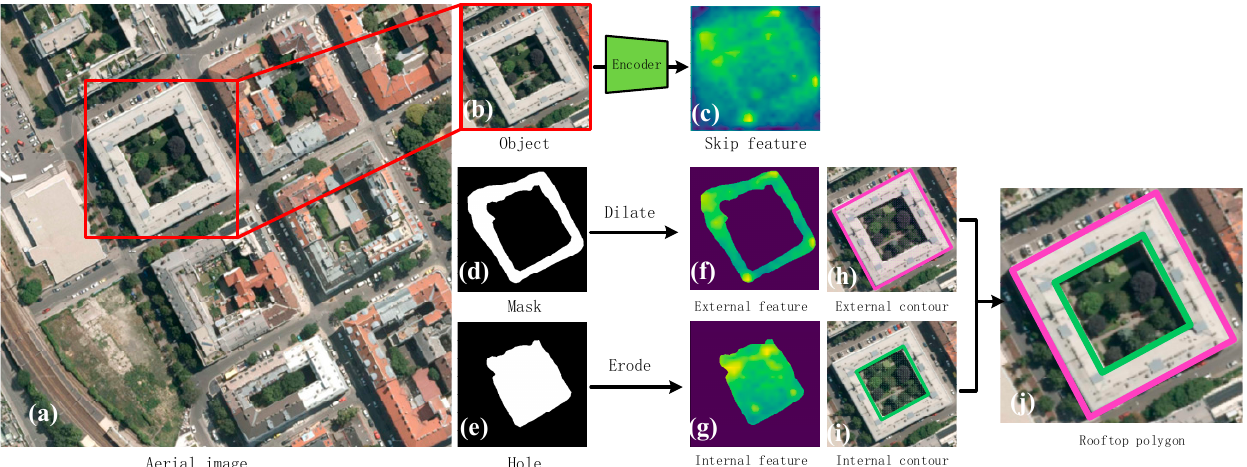
Figure 4. The framework of OEC-RNN for buildings with holes used in this paper: ( a ) original aerial image; ( b ) croped image; ( c ) feature map from the encoder; ( d ) mask result of the rooftop; ( e ) mask result of the hole; ( f ) feature map of the rooftop; ( g ) feature map of the hole; ( h ) polygon of outer contour; ( i ) polygon of hole; and ( j ) polygon of the rooftop with a hole.